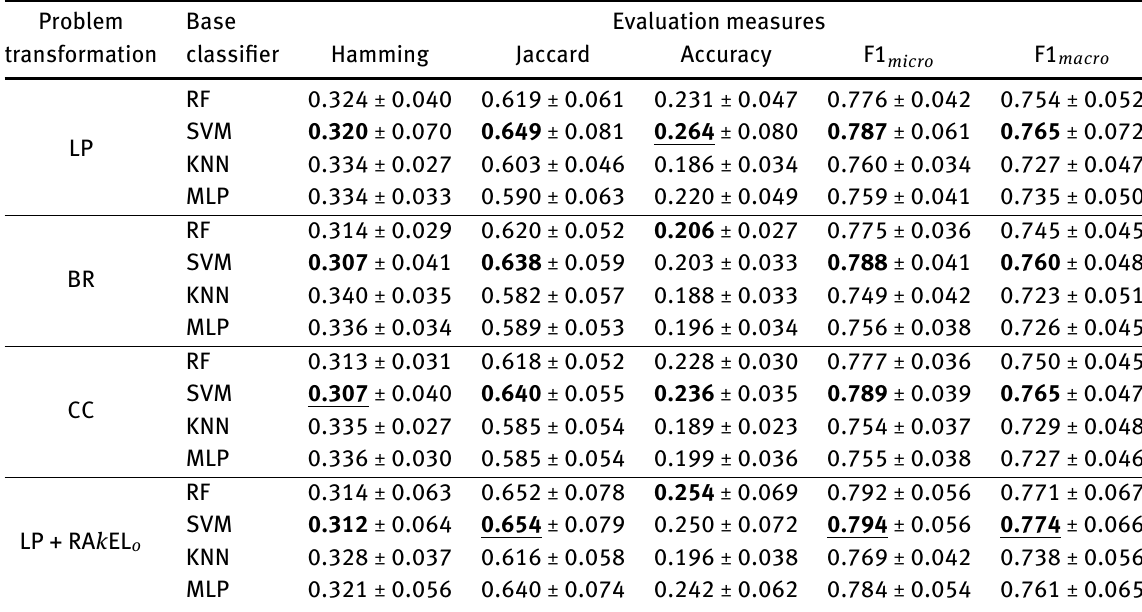
Table 2: Performance comparison using different problem transformation methods (underline – best transformation method in terms of a single metric; bold – best within a single transformation method.)